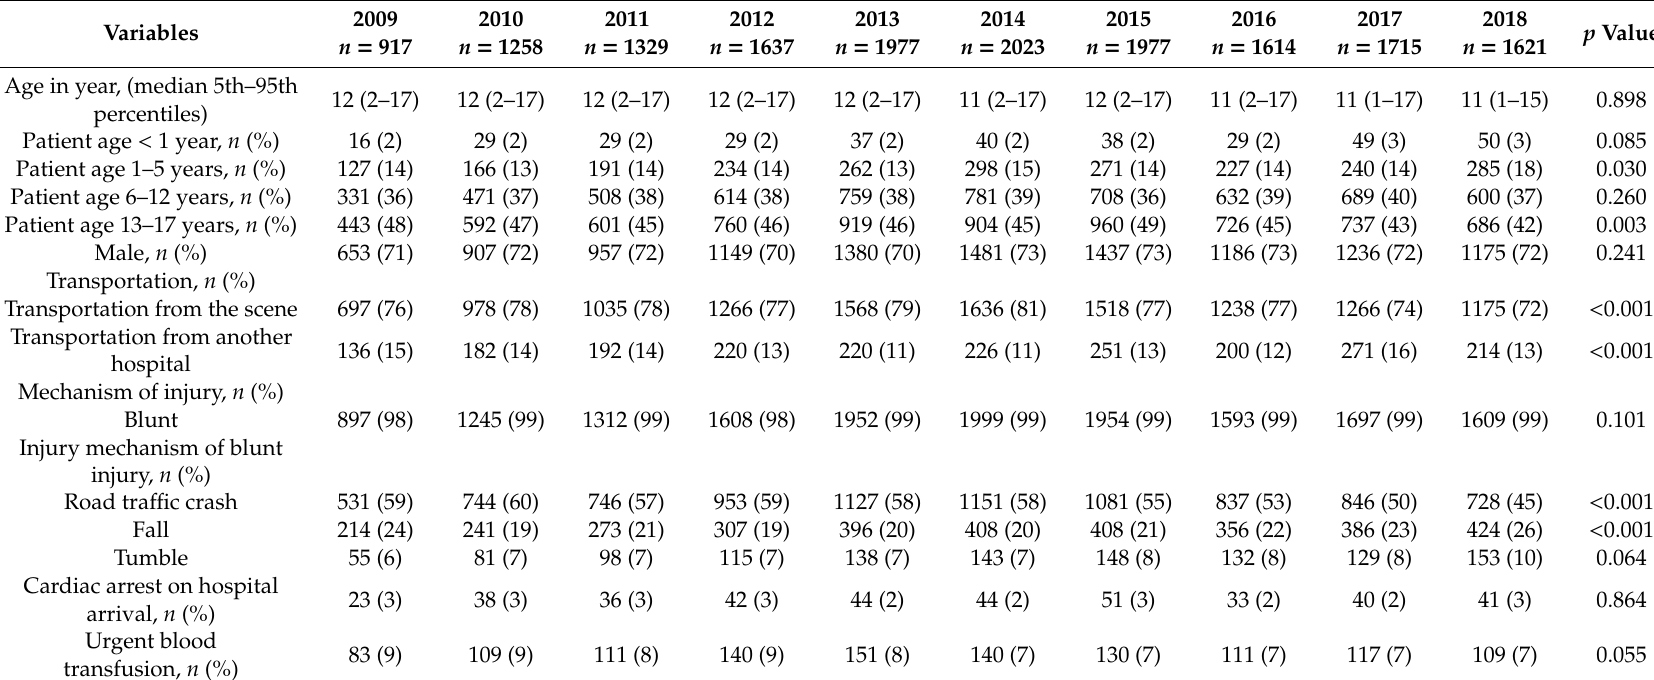
Table 1. Demographics and other data of paediatric injured patients by